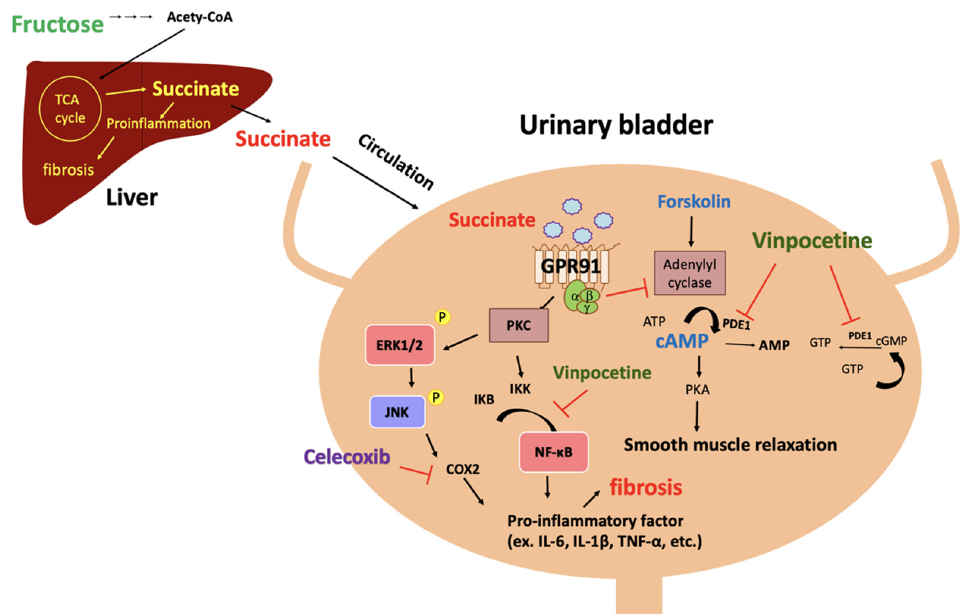
Figure 7. The hypothetic mechanisms of excessive fructose intake raising circulating succinate levels and the following molecular events through GPR91 activation in the bladder. Two negative impacts of succinate/GPR91 activation are concerned: inhibiting the production of detrusor cAMP and eliciting proinflammation along with bladder fibrosis.